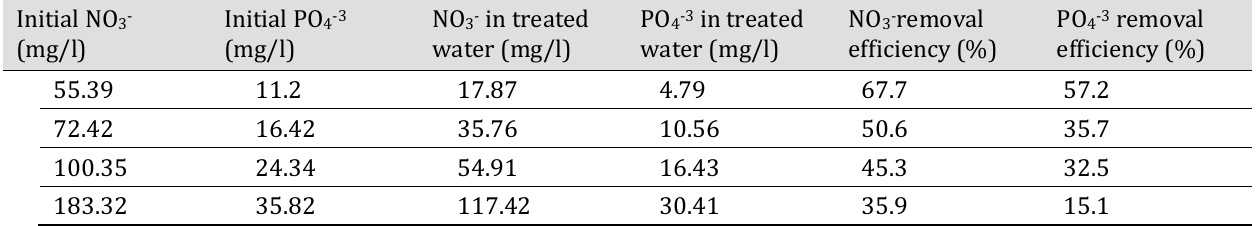
Table 6. MBBR system monitoring under constant hydraulic retention time (HRT) of 6 h and different NO 3-